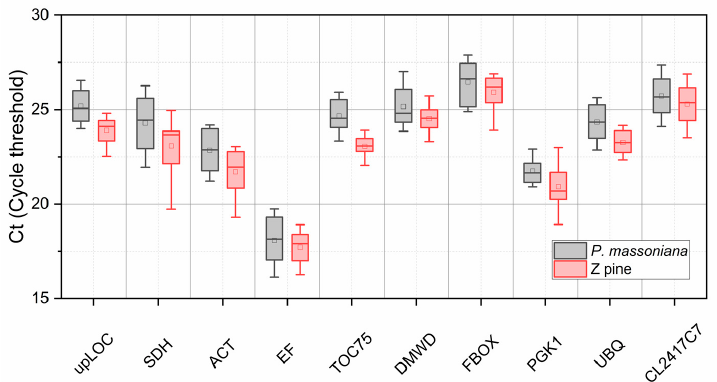
Figure 4. Range of Ct values for ten reference gene candidates across different P. massoniana and Z pine tissues. Ct distribution is presented as a box-plot, indicating the interquartile range (box), median (horizon line in box), average (small square), maximum and minimum value (upper and lower whisker cap).